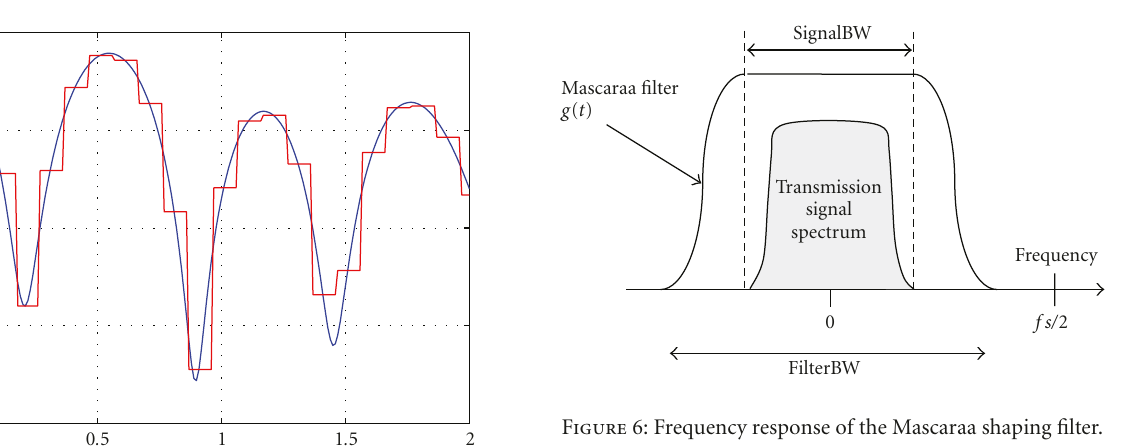
Figure 6: Frequency response of the Mascaraa shaping